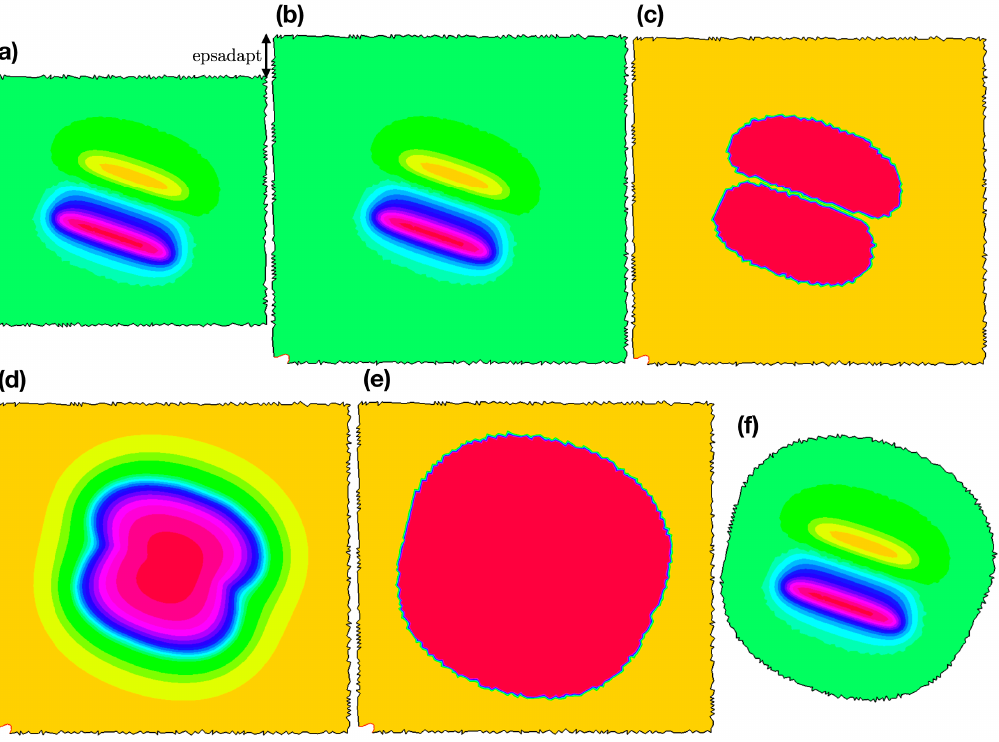
Figure 2. Domain adaptation technique step: ( a ): initial solution, ( b ): the solution unew mapped from the initial solution over a mesh augmented by epsadapt , ( c ): the new H EAVISIDE function unewadapt which have a value of 1 (the red part in the figure) if | unew | ≥ erradapt and 0 otherwise, ( d ): the function usmadapt which is the smoothness of the unewadapt , ( e ): the new H EAVISIDE function ufinal which have a value of 1 (the red part in the figure) if | usmadapt | ≥ erradapt and 0 otherwise, ( f ): mapped of the initial solution to the final domain